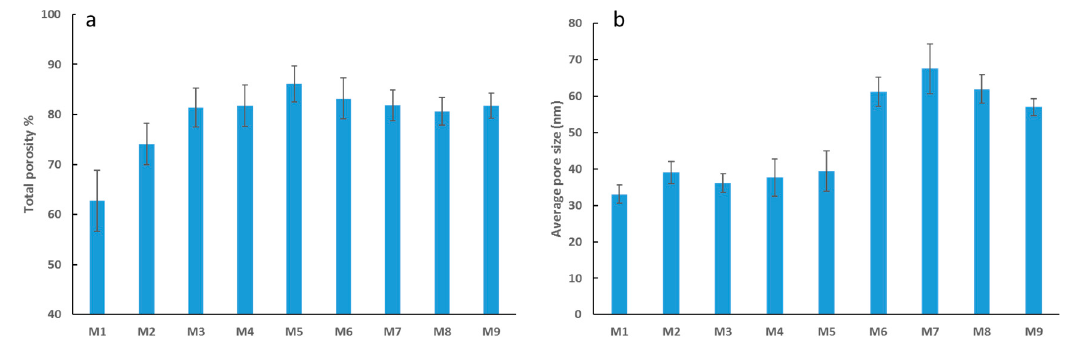
Figure 5. Total porosity of fabricated PES membranes ( a ), and average pore size of fabricated PES membranes ( b ). Each bar represents the mean ± SD (standard deviation) of three independent readings.